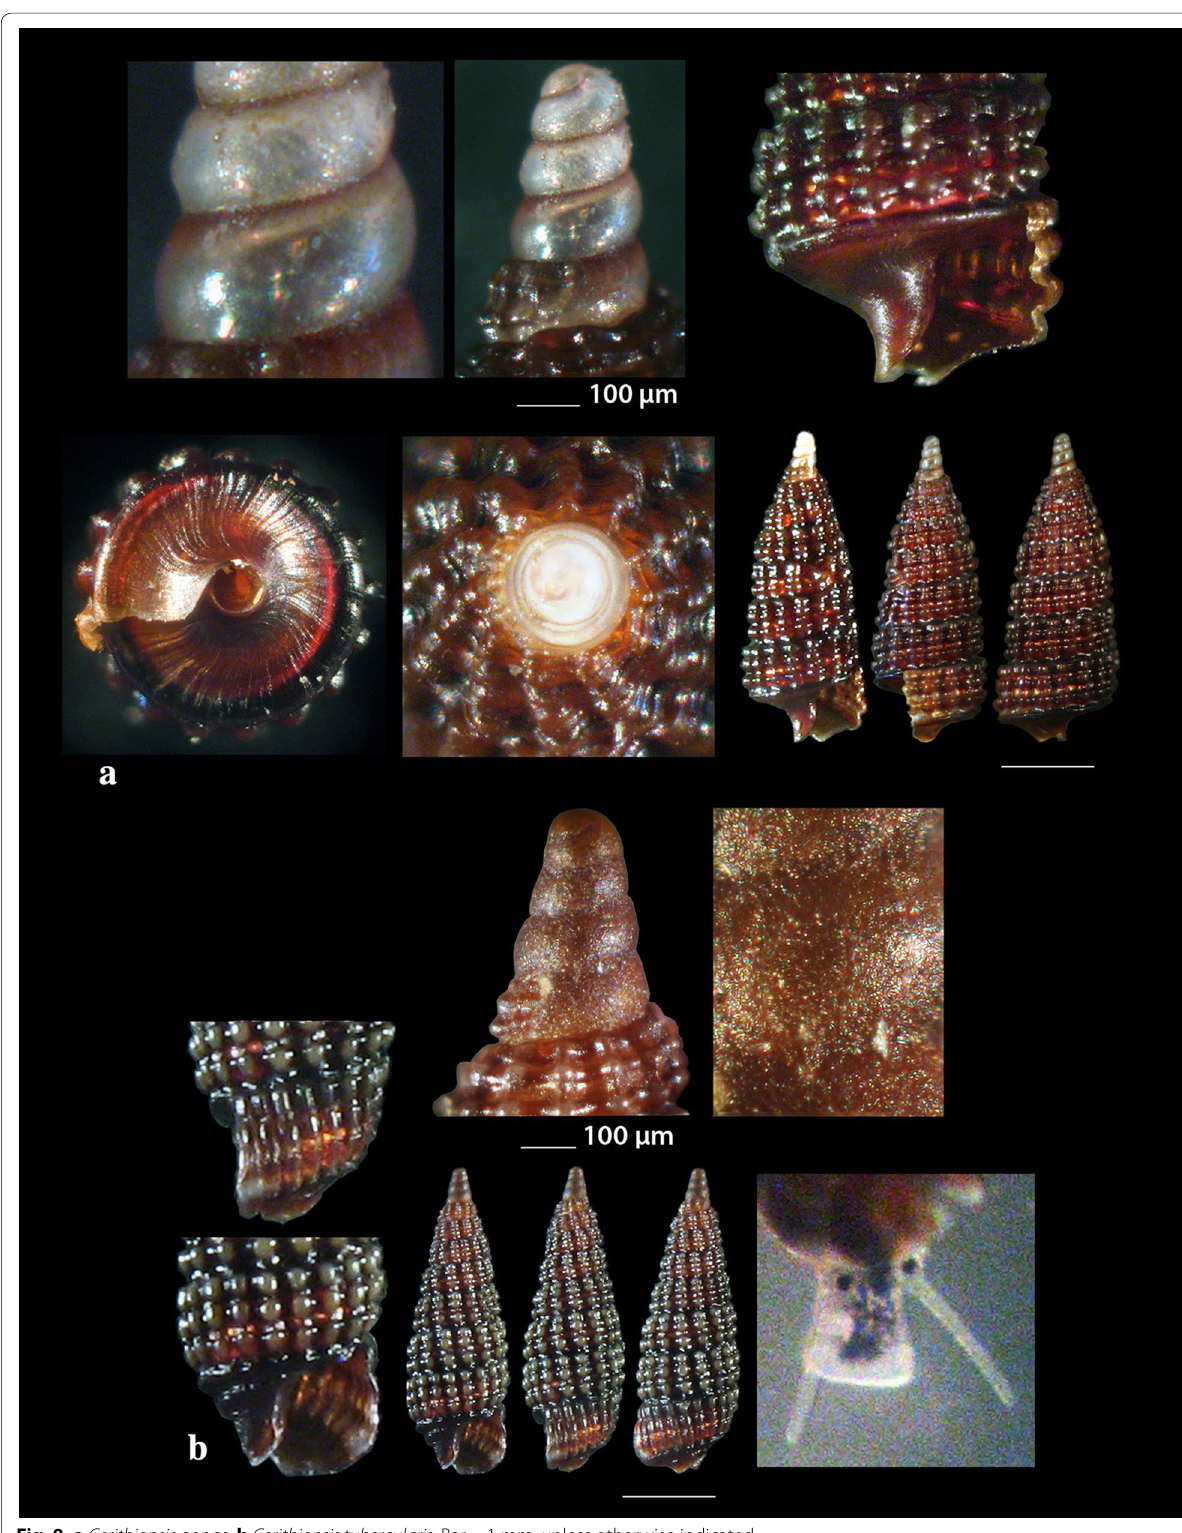
Fig. 8 a Cerithiopsis annae , b Cerithiopsis tubercularis. Bar